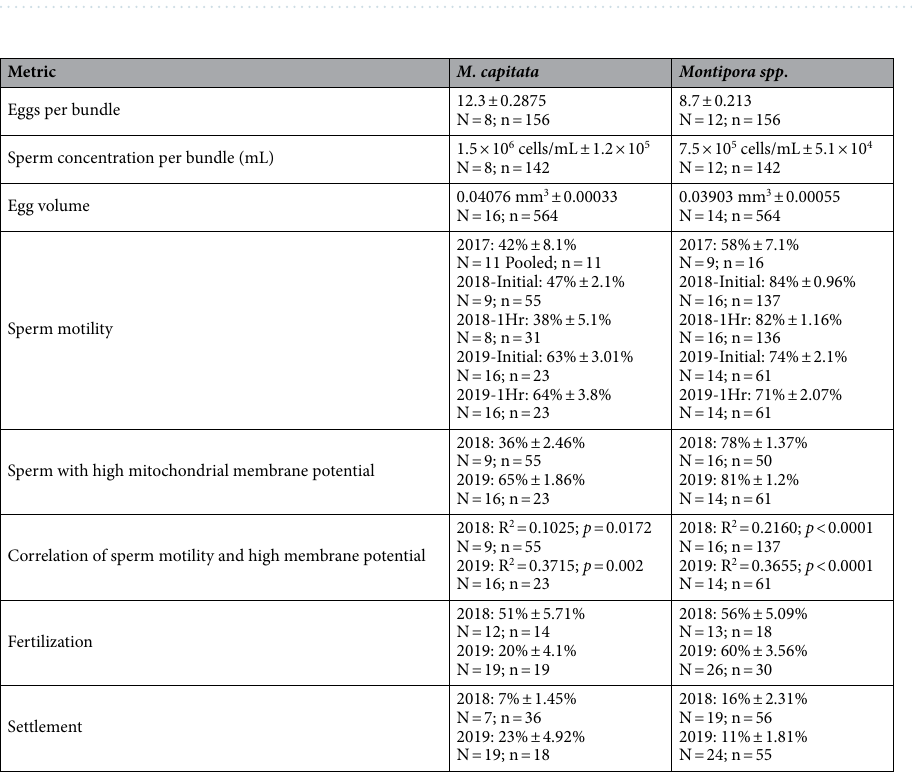
Figure 1. Collection sites for M. capitata and Montipora spp . Colonies were collected across the bay between depths of 1–4 m ( Google Earth Pro v. 7.3.3.7786, www. earth. google. com).